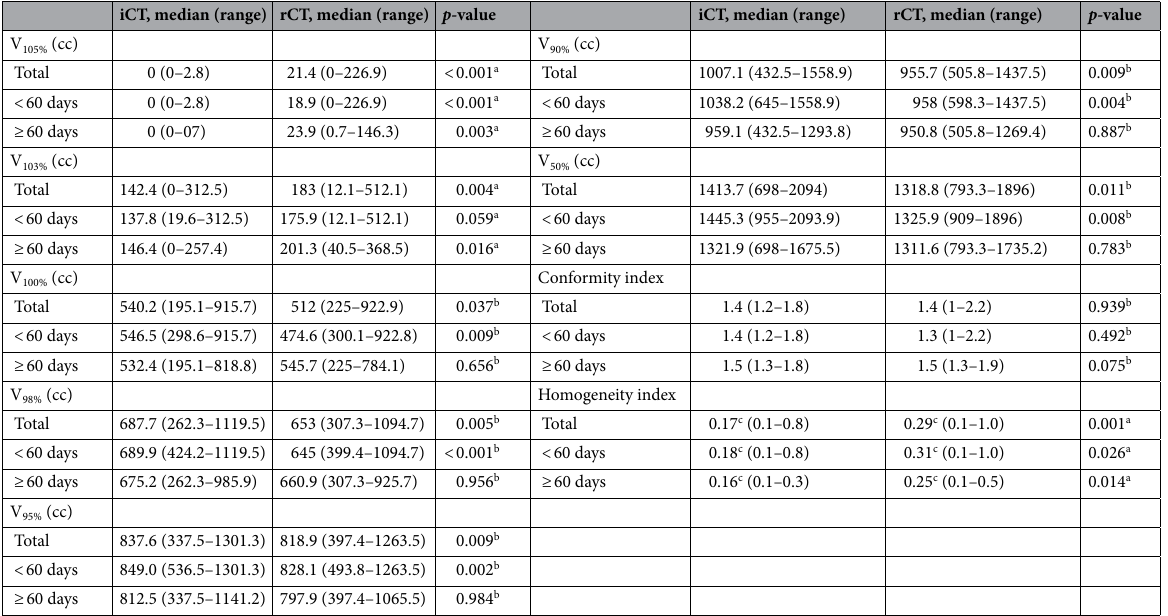
Table 2. Dosimetric comparison of volume parameters and plan quality indices in iCT and rCT (categorization according to the surgery–simulation interval). a Wilcoxon rank sum test, b Paired t-test, c Mean